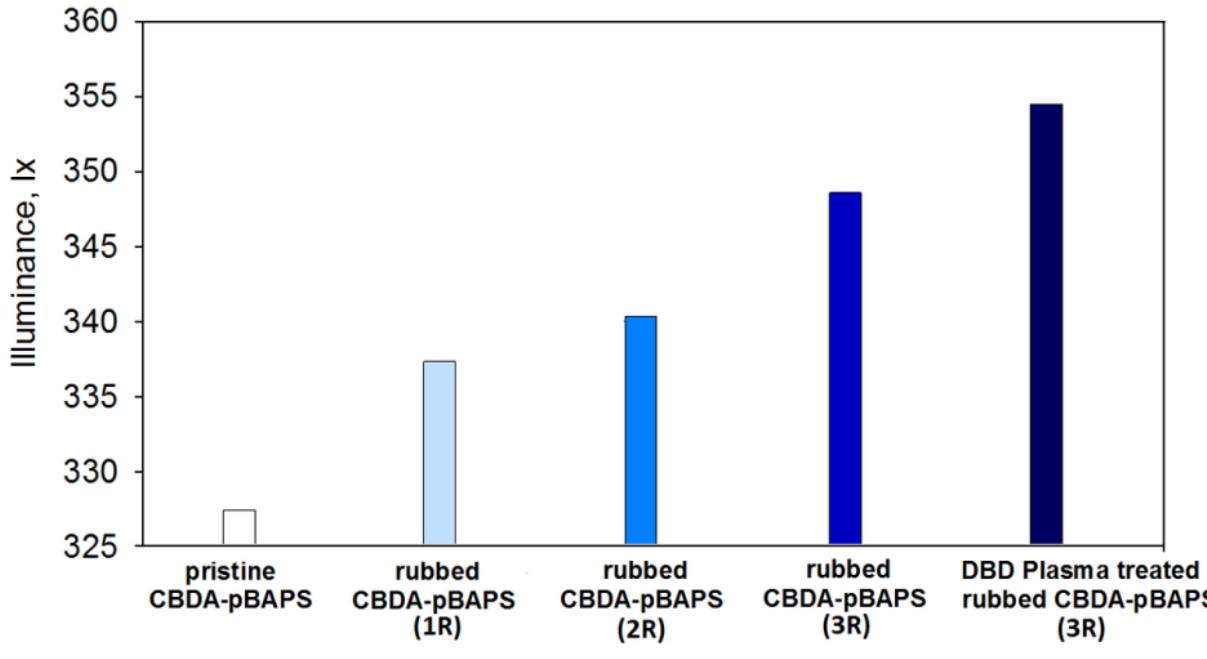
Figure 12. Illuminance variation with each step of the PI surface modification.